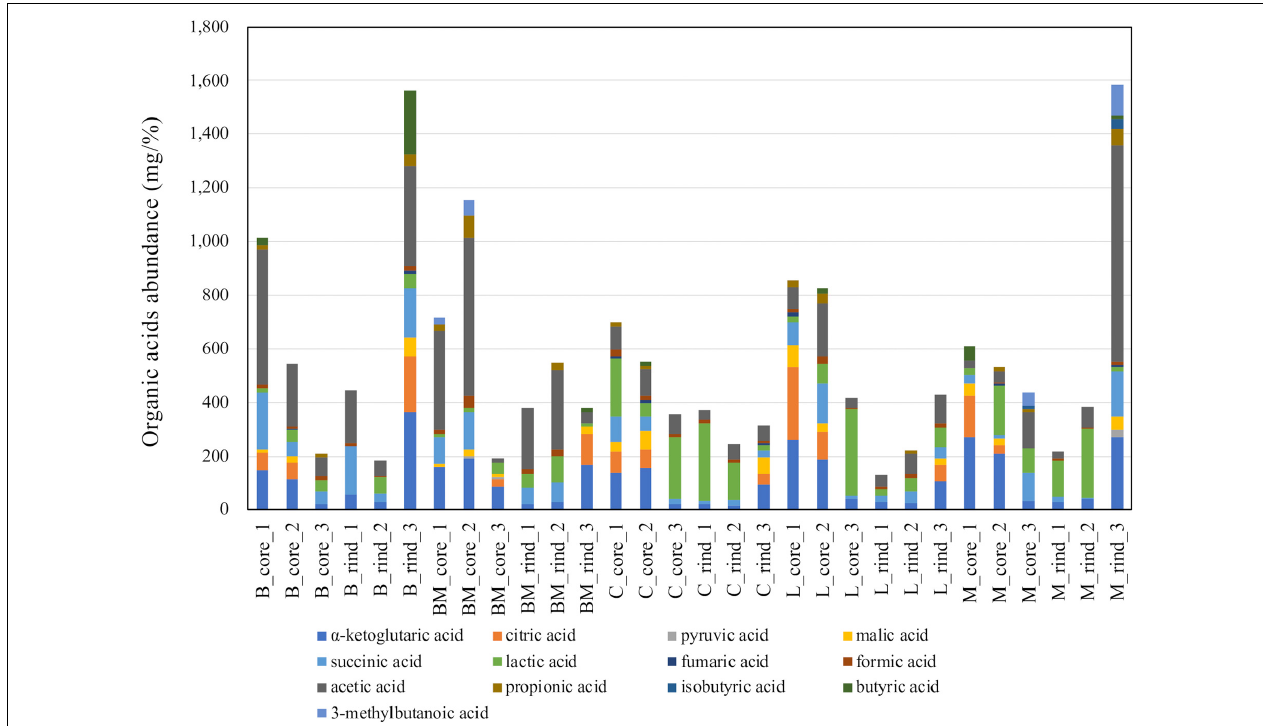
FIGURE 3 | Abundances of organic acids in 30 cheese samples. The total amount of organic acid in each sample is shown in the barplot. B, Brie de Meaux; BM, Brie de Melun; C, Coulommiers; L, Langres; M, Maroilles.